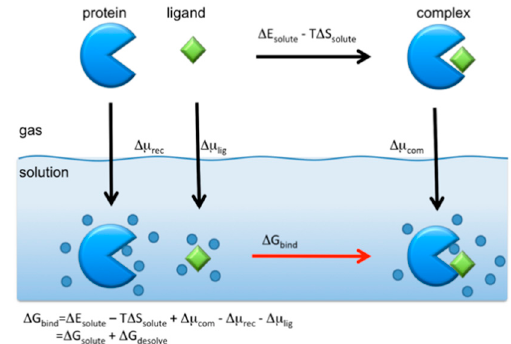
Figure 11. Standard thermodynamic cycle for the protein–ligand binding in aqueous solution. (The figure is reprinted from Ref. [16]. Copyright (2017) American Chemical Society.)